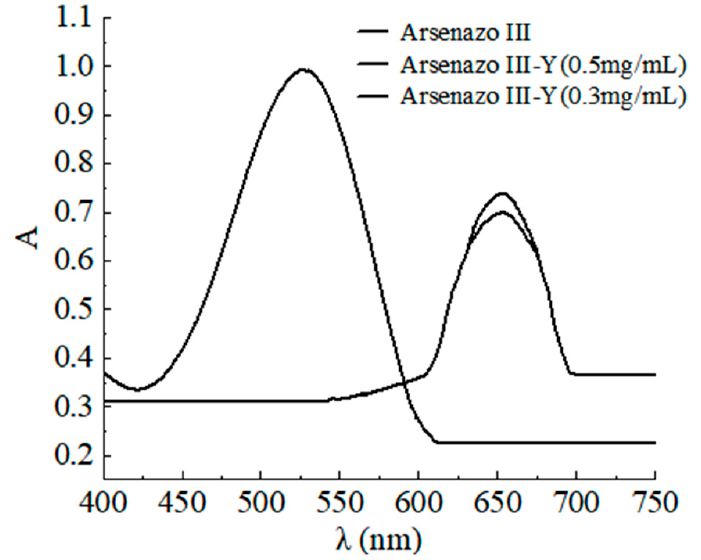
Figure 1. UV-visible absorption spectra.